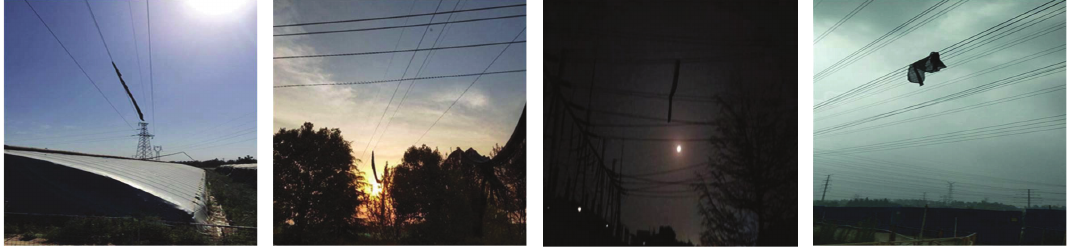
Figure 1. Sample images in the data set. ( a ) Balloons, kites and agricultural plastic which are the main foreign objects hanging on overhead transmission lines. ( b ) Images without foreign objects which have been used as negative samples of the classification task.These negative sample images also contain high-voltage towers and transmission lines, as well as daily images collected by inspection equipment. ( c ) Foreign objects of different sizes. Some tiny foreign objects are not easy to detect. ( d ) Data we collected included not only colorful balloons and kites, but also translucent plastic